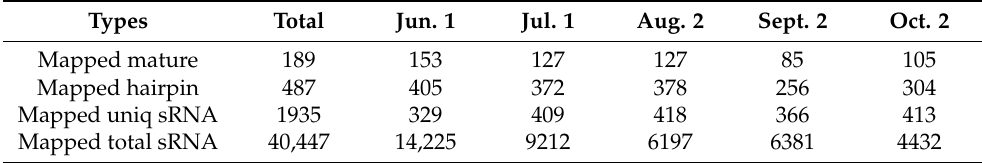
Table 3. Summary of mapped mature and hairpin in known miRNAs.